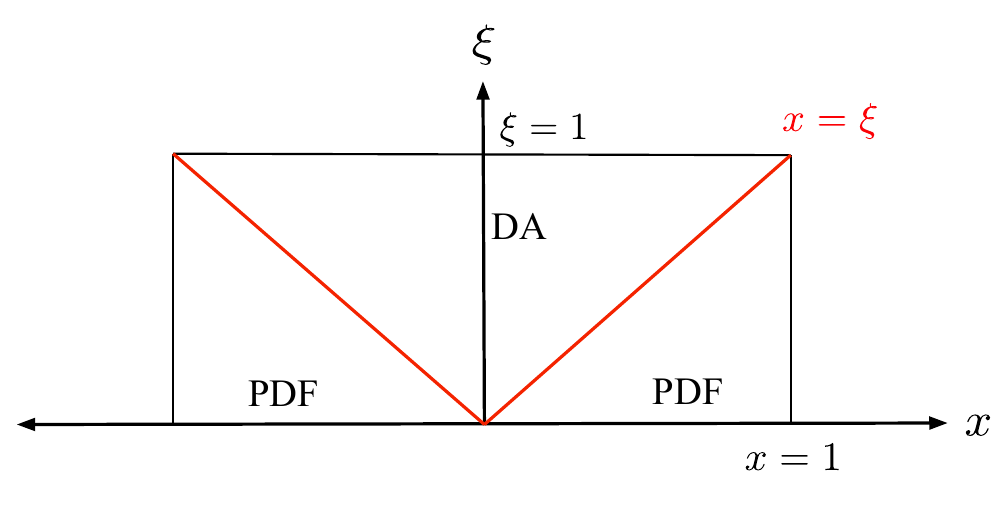
Figure 2 . Graphical representation of the kinematical regions of GPDs on the ( x, ξ ) plane. The GPDs need to be continuous at the crossover line | x | = ξ in order for factorization to work, while their derivatives might not exist